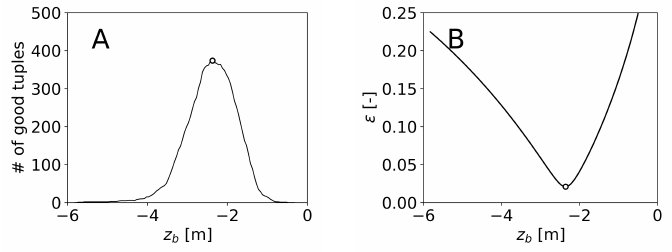
Figure 9. Estimation of z b from tuples ( ω , k , z s ) : RANSAC discard ( A ) and optimization ( B